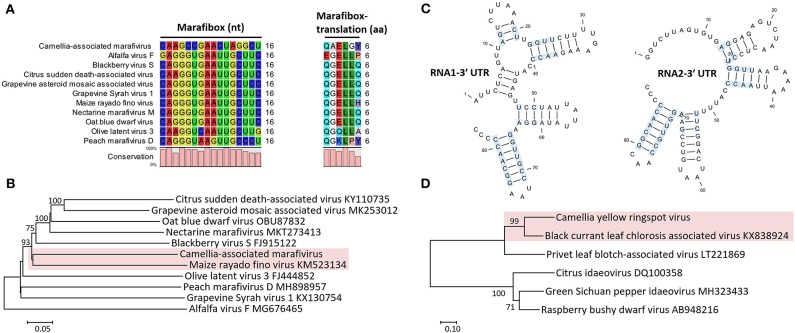
(A) Multiple sequence alignment of Camellia-associated marafivirus (CaMaV) and representative marafiviruses at the marafibox region. (B) Phylogenetic analysis of CaMaV and the marafiviruses based on the whole genome sequences; bootstrap values (1,000 replications) under 50% are pruned. The CaMaV and its closest relative are indicated by the red background. (C) Phylogenetic relationships inferred from the conserved coat protein (CP) amino acid sequences of Camellia yellow ringspot virus (CaYRSV, the idaeovirus) and representative idaeoviruses, with CaYRSV and the closest relative backgrounded by red. Significant bootstrap values that were greater than 50% (1,000 replications) are shown. (D) Secondary structure of 3′ untranslated regions (3′ UTR) of genomic RNAs of CaYRSV. The blue background highlights the identical nucleotides between the stem-loops of RNA1 and RNA2.